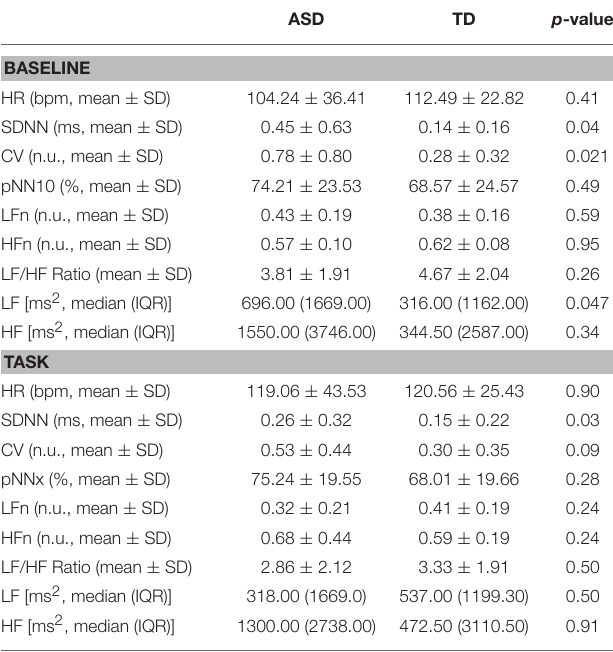
TABLE 2 | Comparison between the two study groups in all the single ECG features extracted in the single testing phases (significance: p < 0.05). ASD TD p